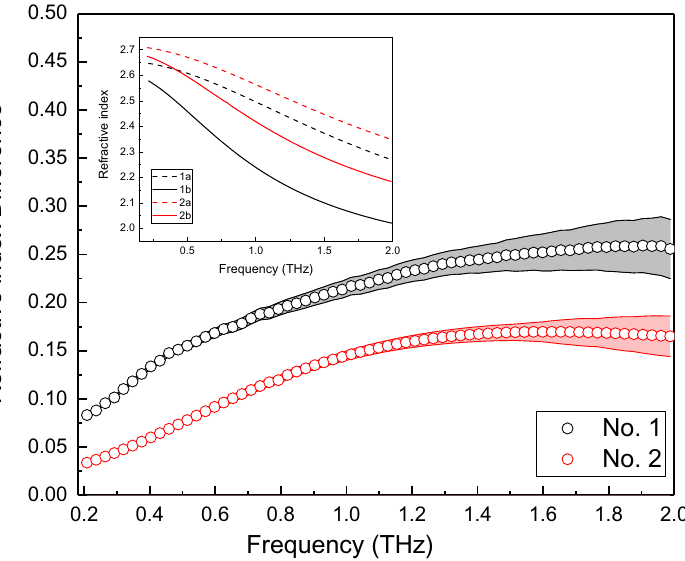
Figure 6. Refractive index versus frequency for the cornea No. 1 and No. 2. Insert Figure: refractive index of cornea No. 1 and No. 2. 1a and 2a indicate the curves after the light stress, while the 1b and 2b indicate the curves before the light stress.